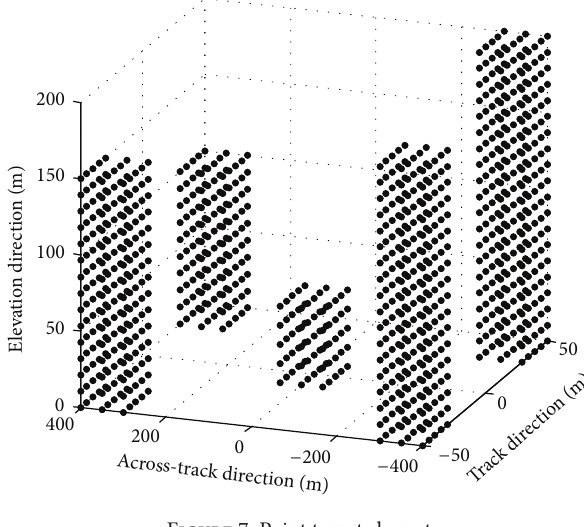
Figure 7: Point targets